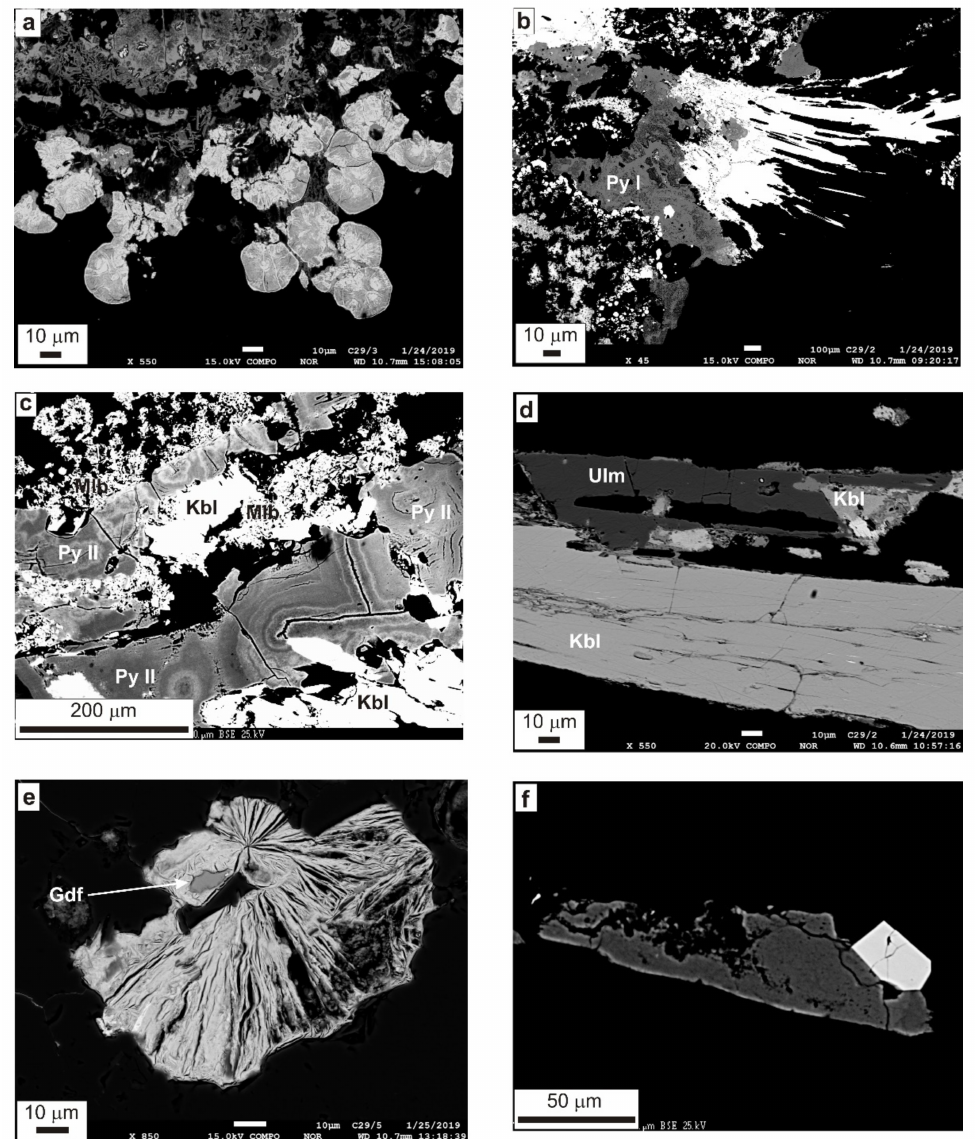
Figure 5. ( a ) Globular aggregates of uraninite (white) that are intensively replaced by an unidentified supergene uranyl mineral (light grey) in contact with the U-Ti oxides (tones of dark grey, top of the picture). ( b ) Pyrite I (Py I) overgrown by kobellite, uraninite, molybdenite, sulphotellurides and other ore minerals (white). ( c ) Veinlets of zonal pyrite II (Py II) cutting accumulations of molybdenite (Mlb) and kobellite–tintinaite series minerals (Kbl). ( d ) Kobellite (Kbl) in contact with ullmannite (Ulm). Ullmannite is overgrown and replaced with kobellite and jos é ite-B (white). Quartz is black. ( e ) Relic of gersdorffite (Gdf) overgrown by zeunerite (light grey) in a quartz cavity (black). ( f ) Cobaltite (white) and pyrite (dark grey) in quartz. BSE, photos by T. Mikuš ( a , b , d , e ) and M. Števko ( c , f